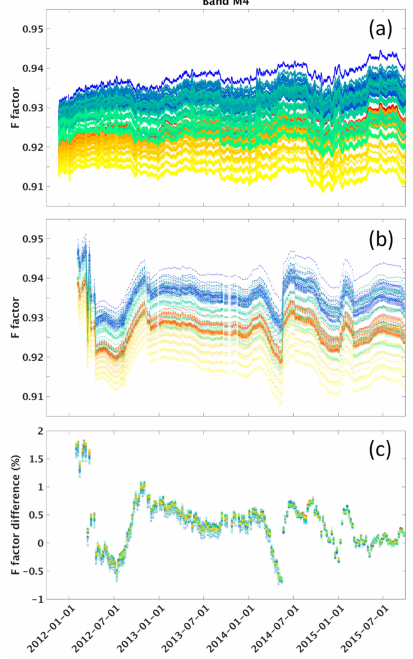
Figure A3. ( a ) VIIRS band M4 (555 nm, dual gain) radiometric calibration scaling coefficients (the F factors) derived by the automated calibration procedure; ( b ) the F factors used in the operational production of the VIIRS SDR; and ( c ) relative difference between the operational F factors and the reprocessed ones (used here as a baseline). Symbol legend is the same as in Figure 4.